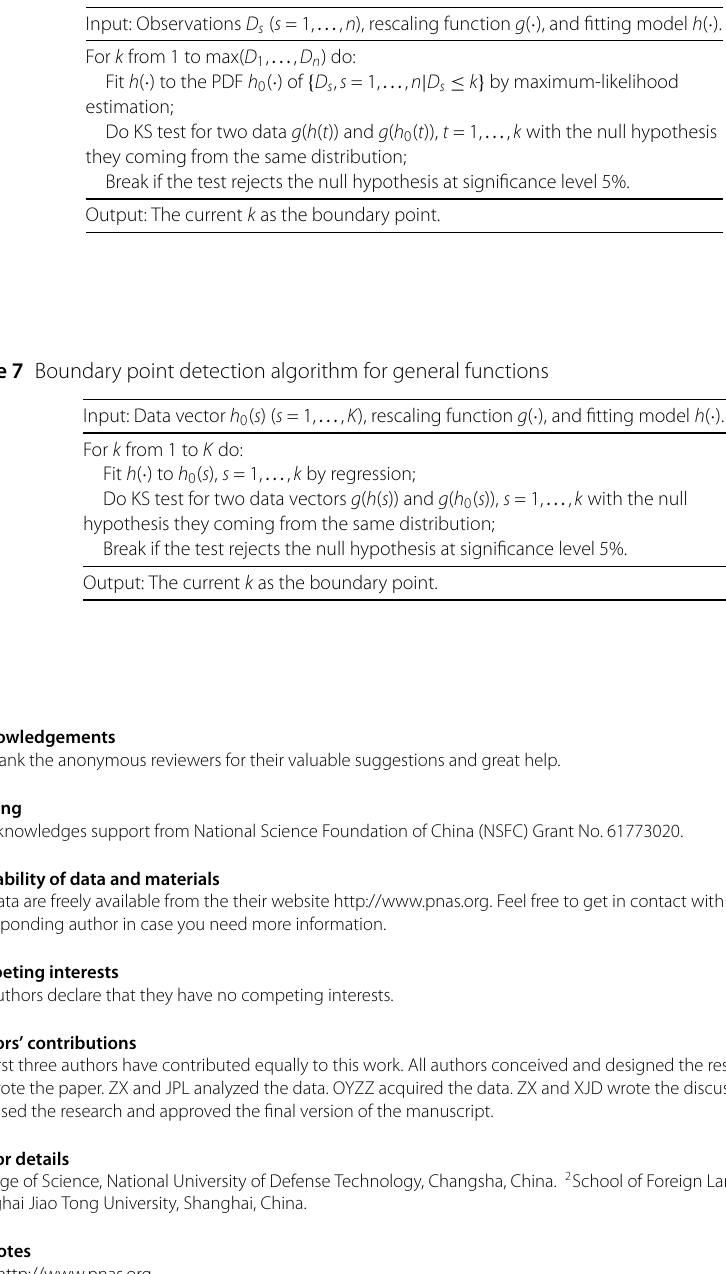
Table 6 A boundary detection algorithm for probability density functions